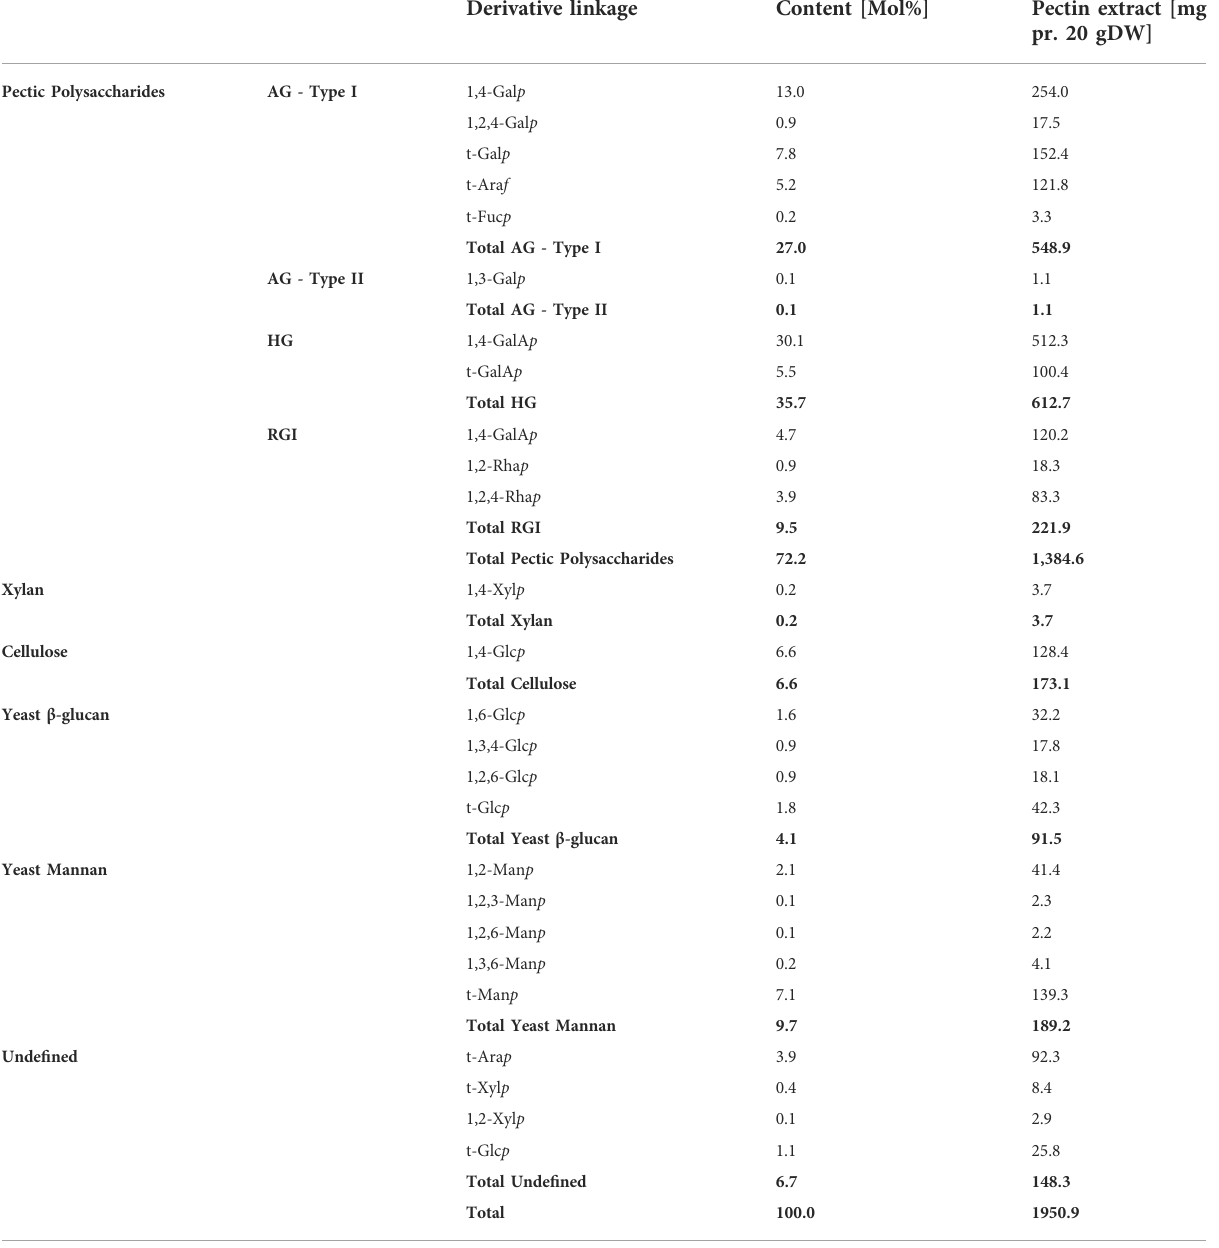
TABLE2Carbohydratelinkagesofeachofthemonosaccharidesweredeterminedbylinkageanalysis.Thevalueslistedarethemolarpercentage,and the mg is reported as dehydrated mass. AG – Arabinogalactan, HG – Homogalacturonan, and RGI – Rhamnogalacturonan I. Values in bold are summarizing the values of the polysaccharide type